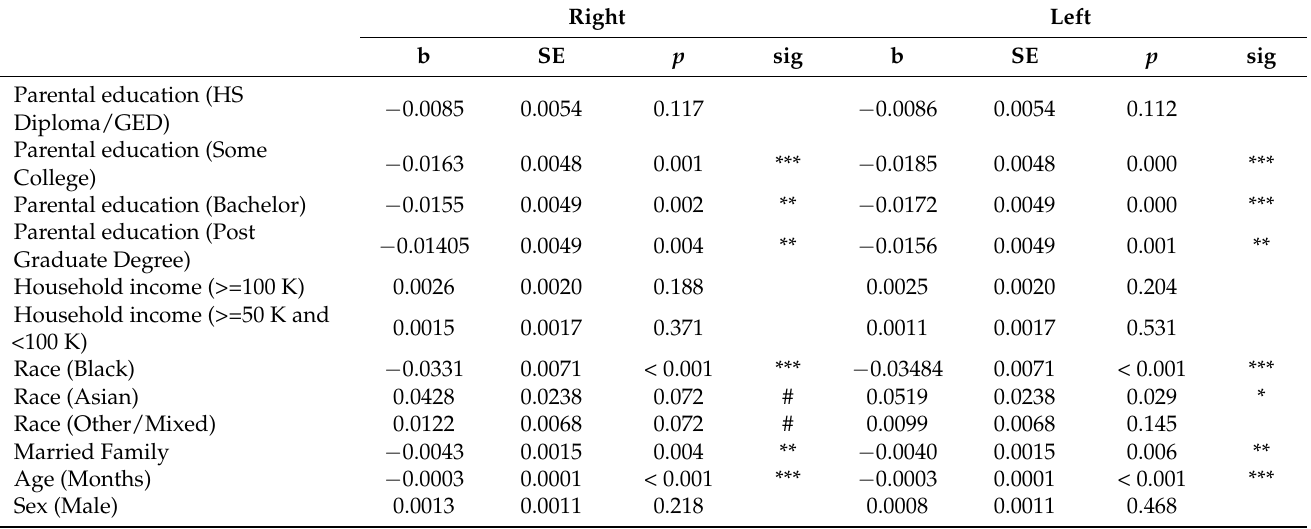
Table 4. Regressions on the association between parental education with right and left cerebellum cortex fractional